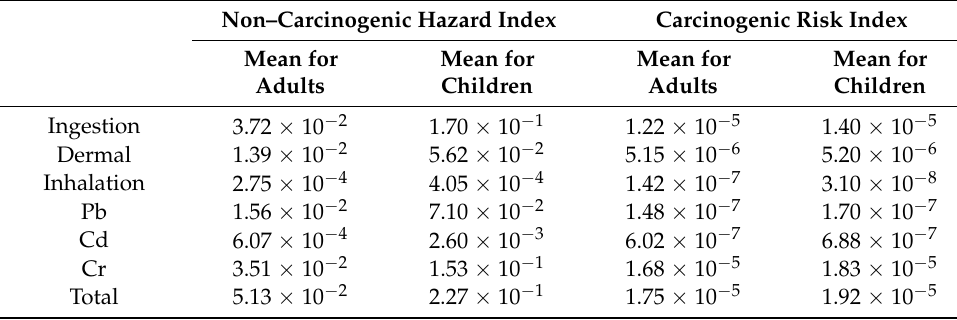
Table 2. Health risk assessment of different routes and heavy